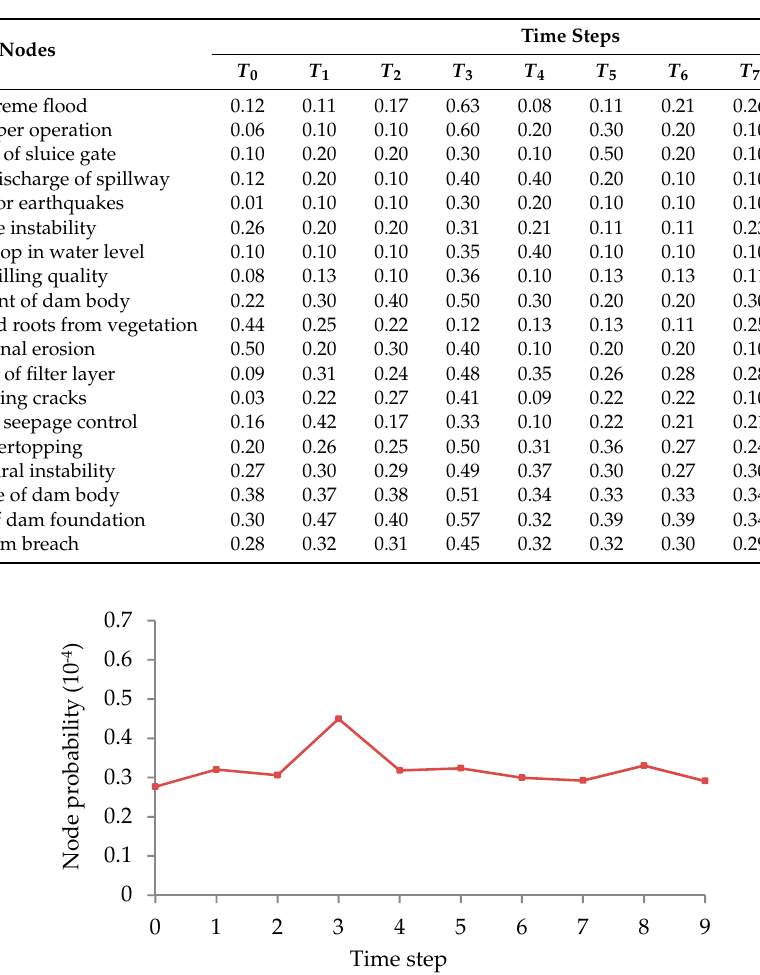
Table 7. Dynamic reasoning results ( × 10 − 4 ).